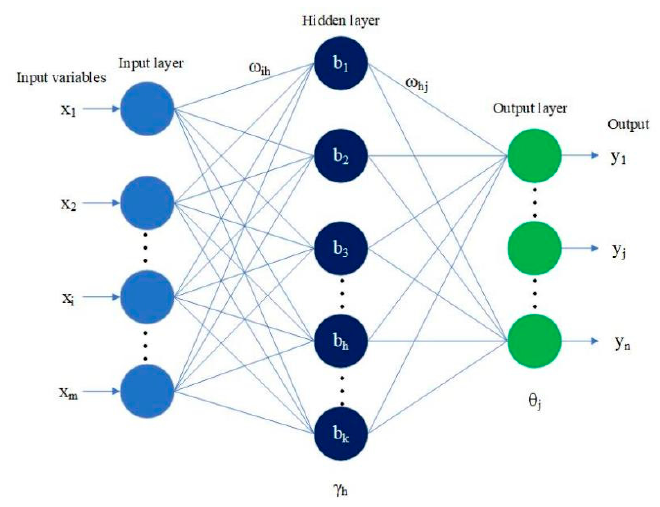
Figure 3. Neural network structure.